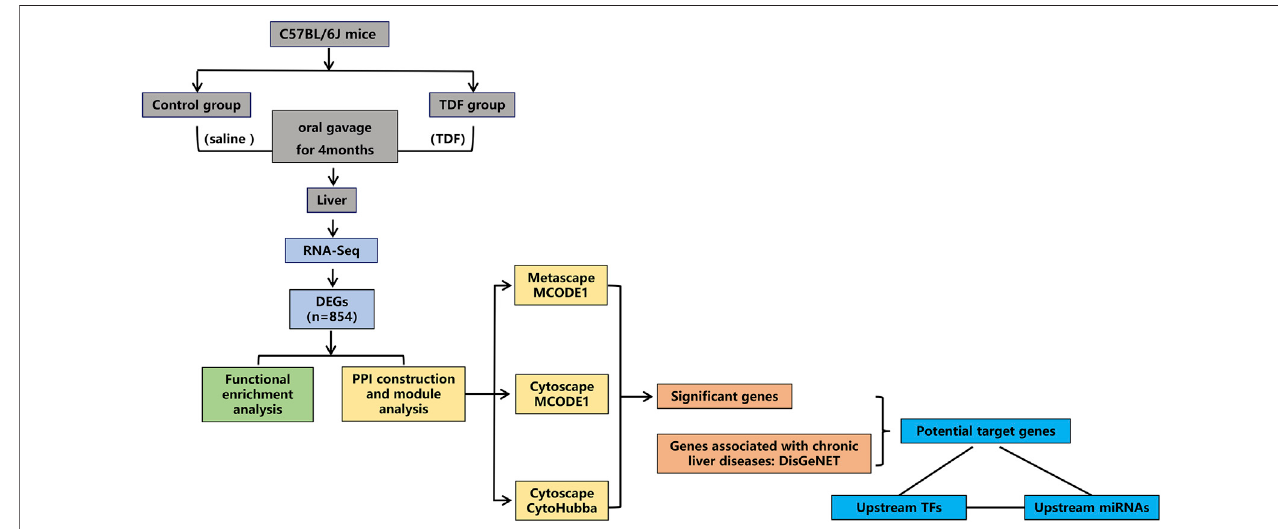
FIGURE 1 | Flowchart of this